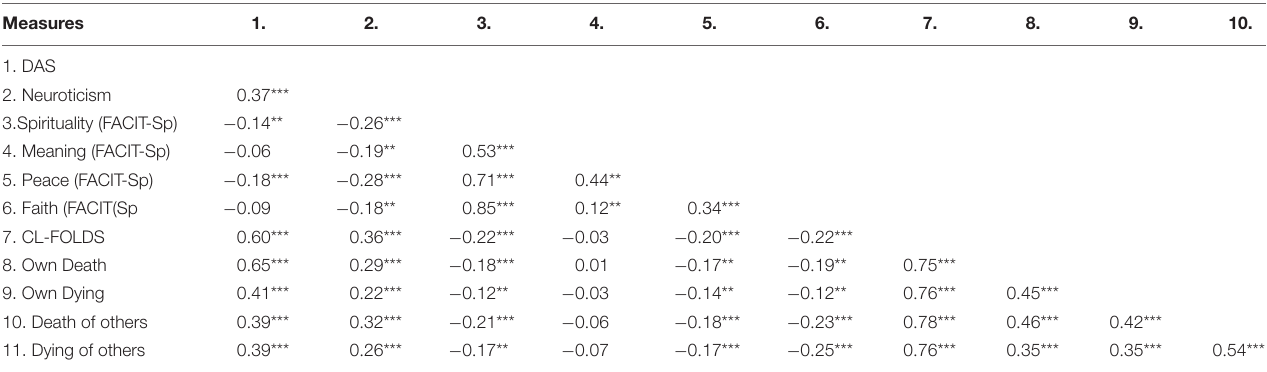
TABLE 4 | Correlations between the Revised CL-FODS, Death Anxiety Scale (DAS), Neuroticism, and Spirituality (FACIT-Sp).